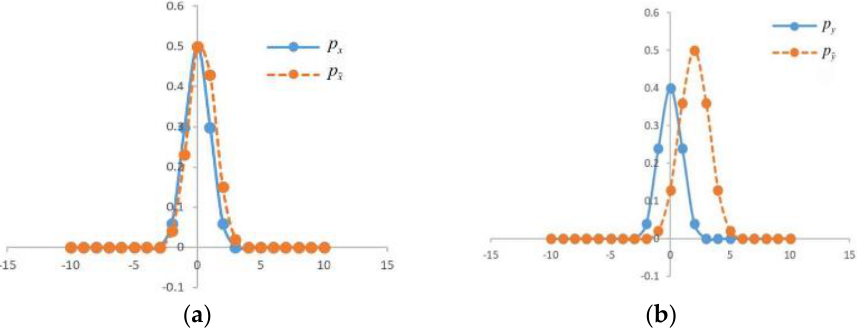
Figure 11. Original images and reconstructed images during training. ( a ) 10 iterations results; ( b ) 100 iterations results; ( c ) 200 iterations results.